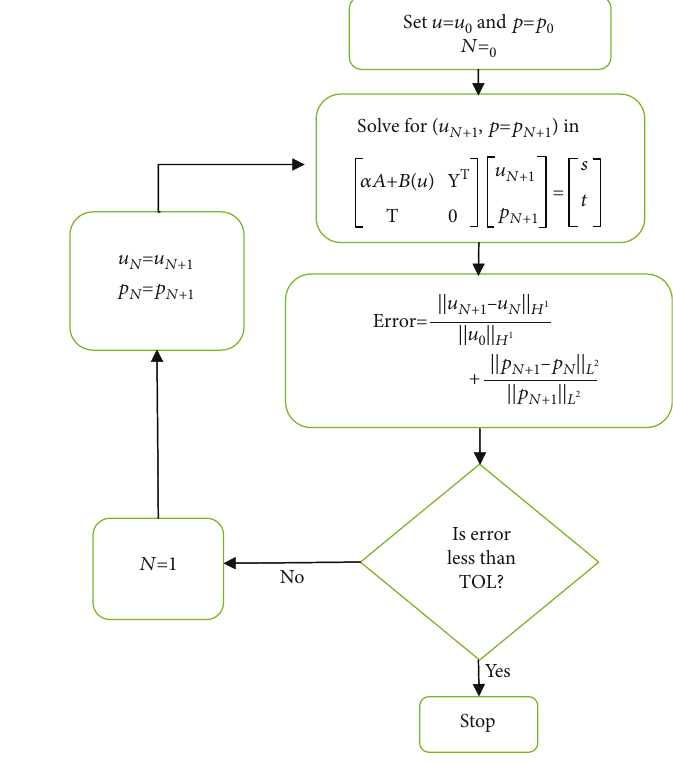
Figure 6: Steps of the set-up algorithm.